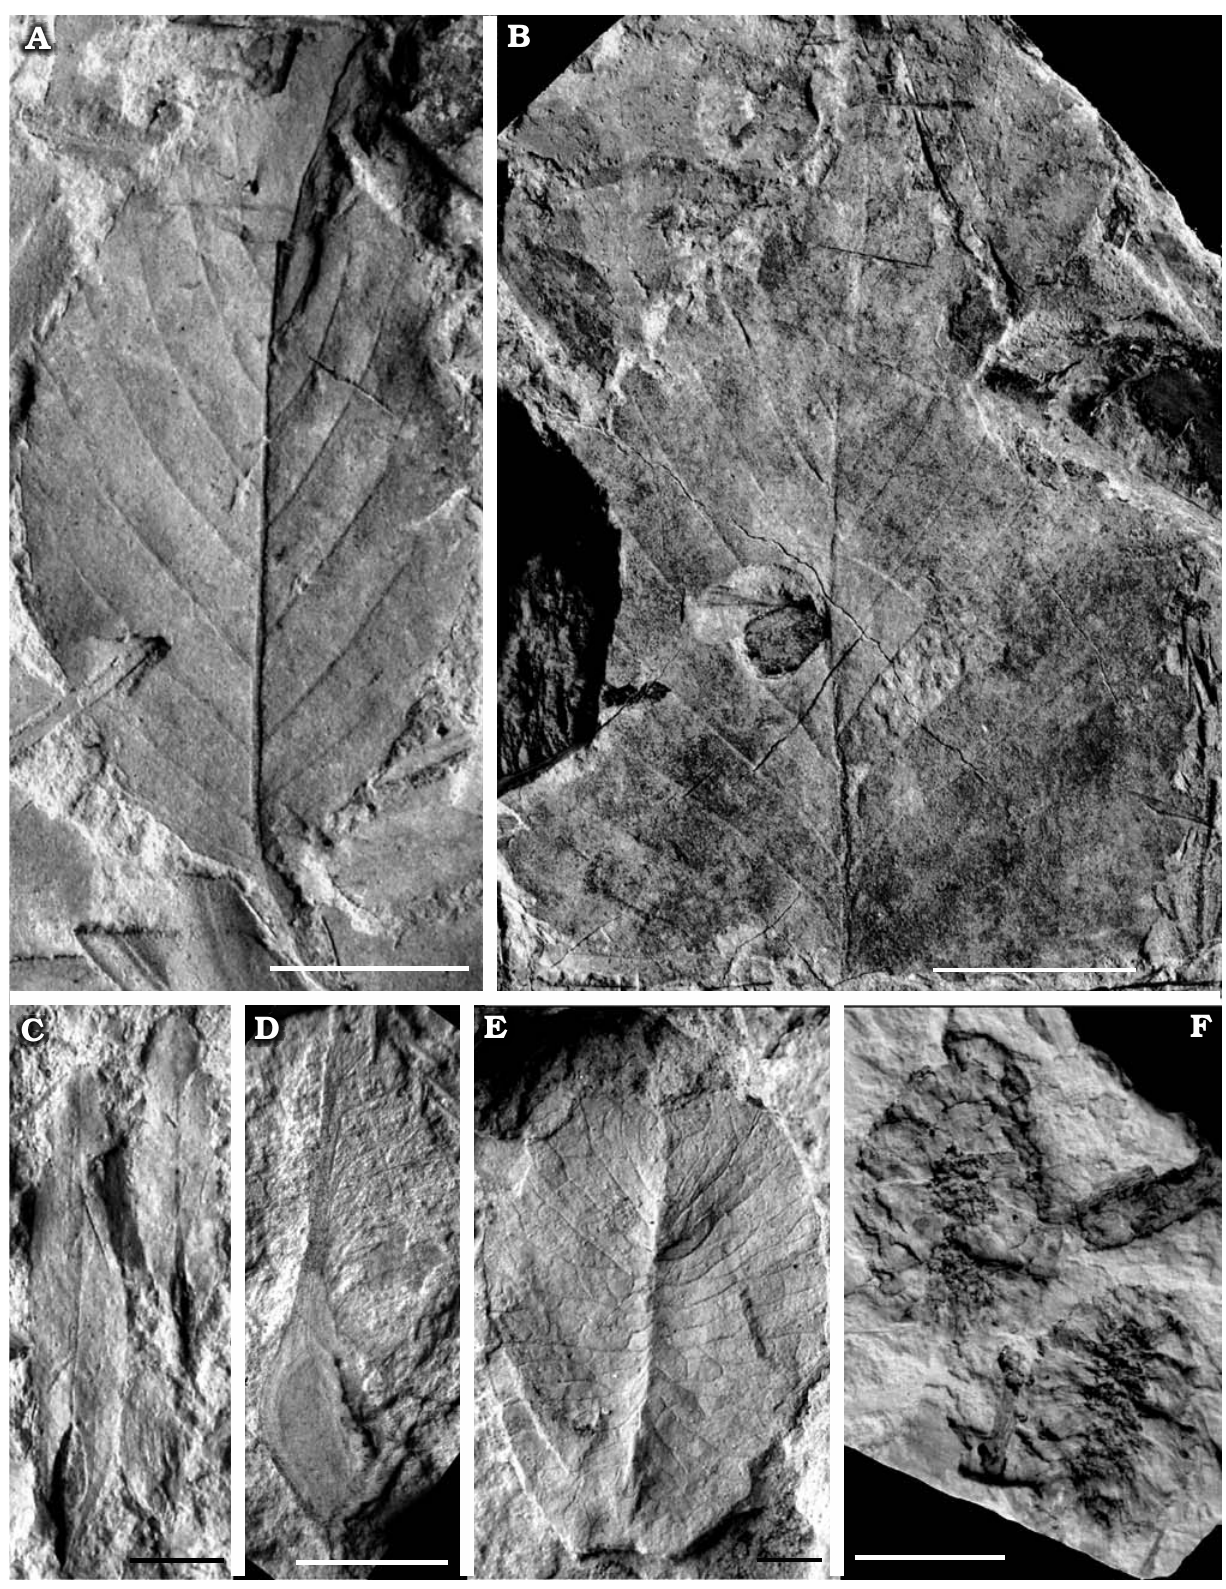
Fig. 3. Angiosperms impressions from Ł ysa Góra near R ę biszów, Poland, late Oligocene. A . Alnus julianiformis (Sternberg, 1823) Kva č ek and Holy, 1974, KRAM-P 128/347, leaf. B . Ulmus fischeri Heer, 1856, KRAM-P 128/149, leaf. C . Liriodendron haueri Ettingshausen, 1869, KRAM-P 128/318, fruit. D . Acer cf. hercynicum Mai, 1978, KRAM-P 128/118, fruit. E . Craigia bronnii (Unger, 1845) Kva č ek, B ů žek, and Manchester, 1991, KRAM-P 128/203, fruit. F . Alnus kefersteinii (Goeppert, 1838) Unger, 1845, KRAM-P 128/44, infructescence. Scale bars: A, B, F, 10 mm; C, D, 5 mm; E, 2